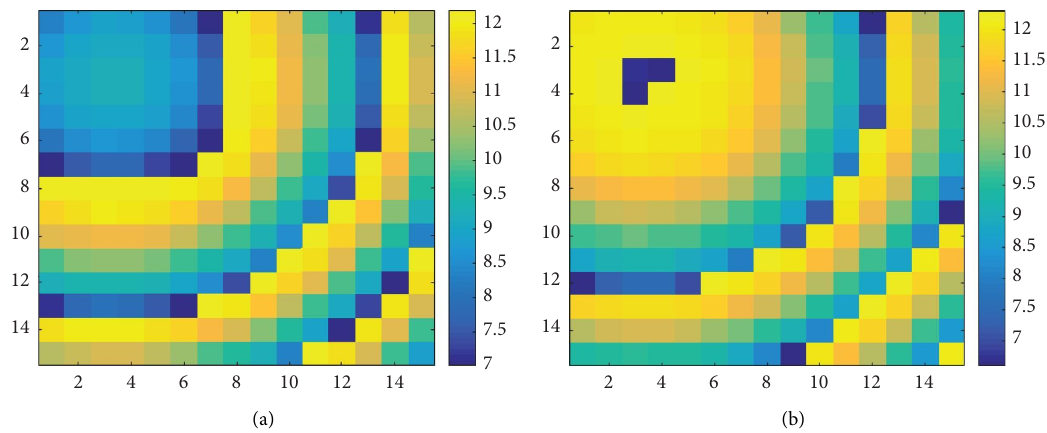
Figure 12: Unit cell size distribution: (a) the length parameter lx and (b) the length parameter ly .